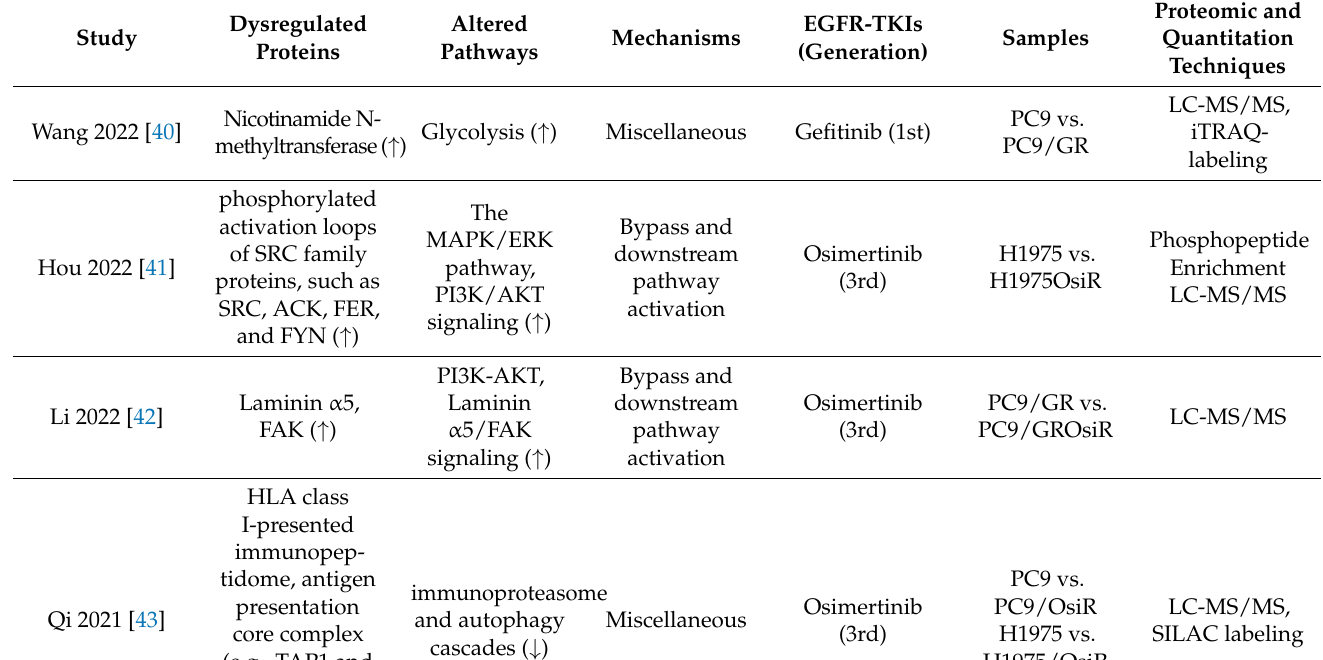
Table 2. Summary of proteomic studies in EGFR-TKI resistant in